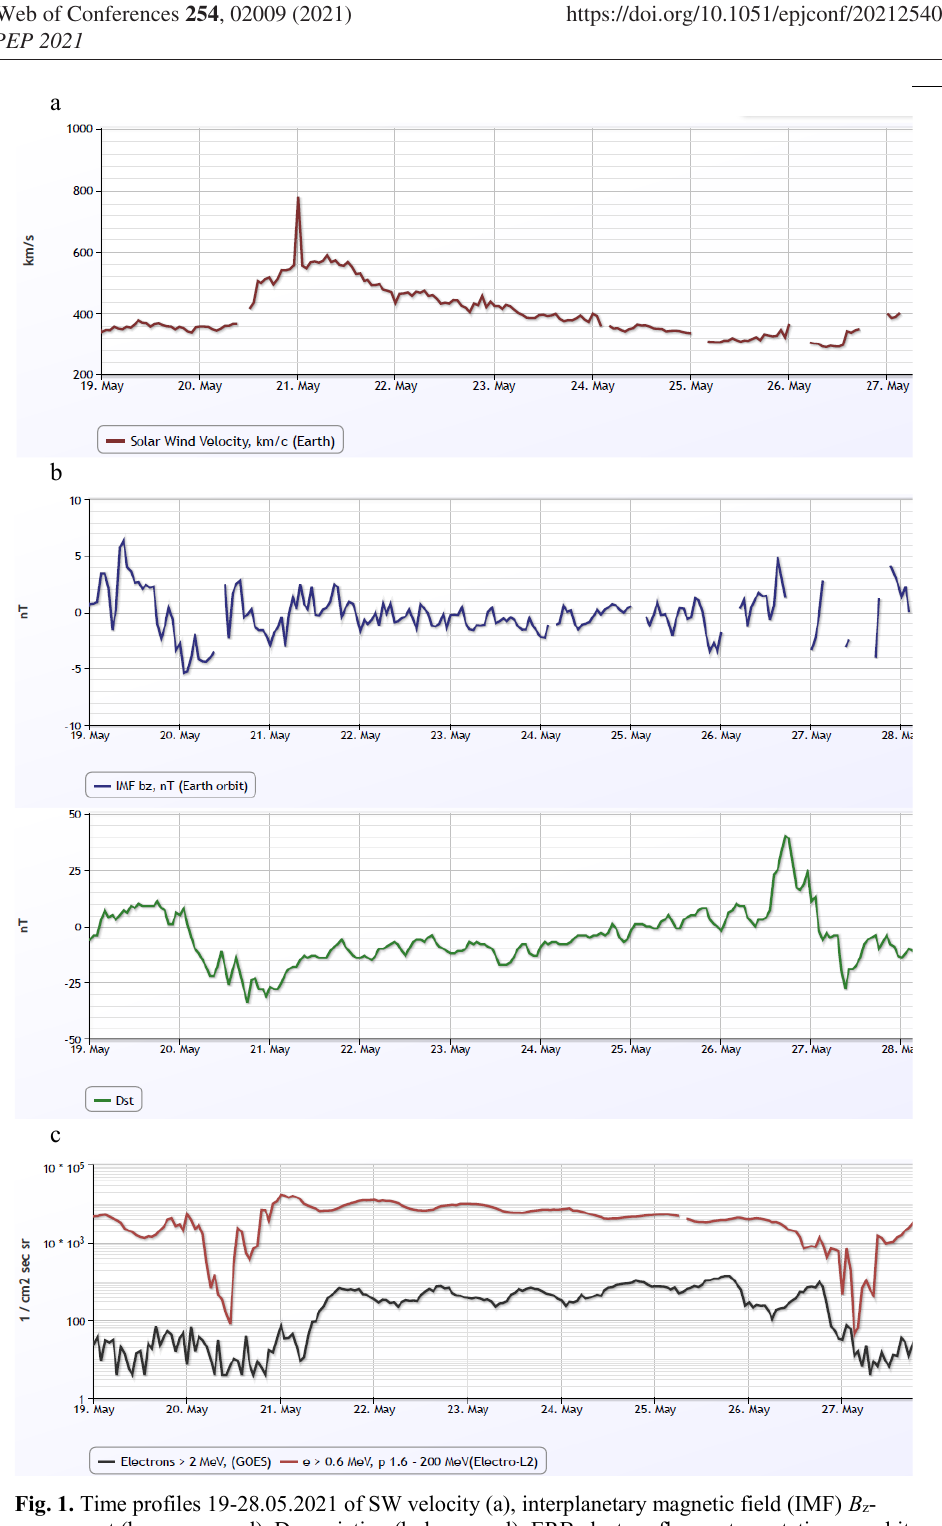
Fig. 1. Time profiles 19-28.05.2021 of SW velocity (a), interplanetary magnetic field (IMF) B z - component (b, upper panel), D st -variation (b, low panel), ERB electron fluxes at geostationary orbit